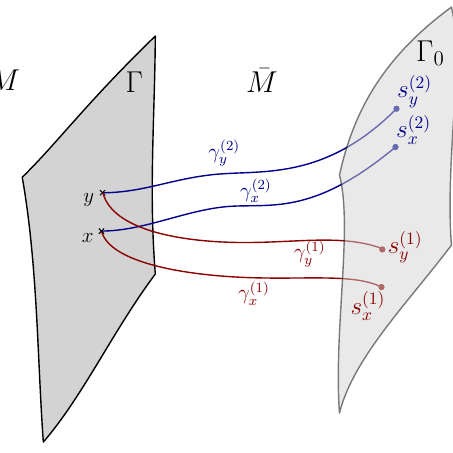
Figure 5 . Two systems of paths γ (1) and γ (2) , supporting distinct families of Wilson lines. They generate two distinct group-valued reference frames U